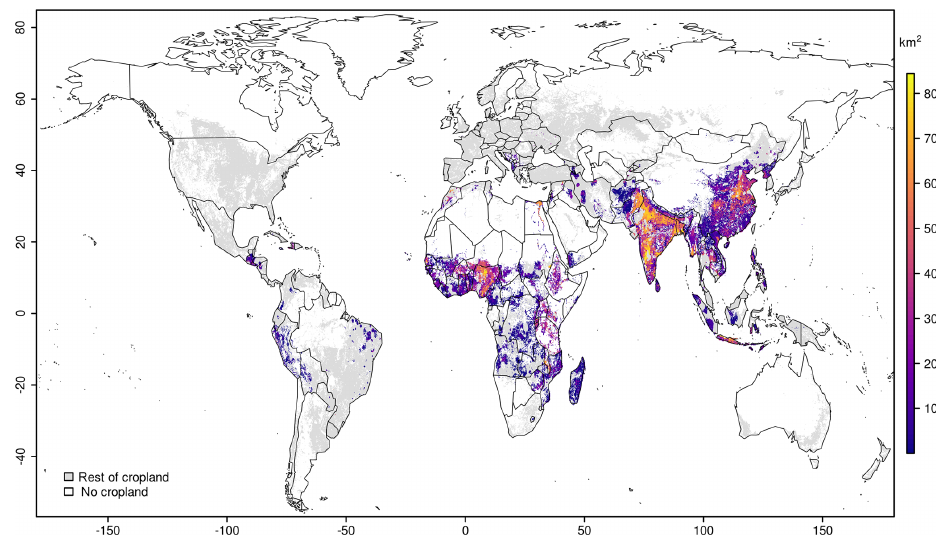
Figure 3. Traditional annual tillage area as sums over 29 annual crop types’ areas in grid cells reporting dominant field sizes smaller than 2ha and in countries classified as low income in this study.